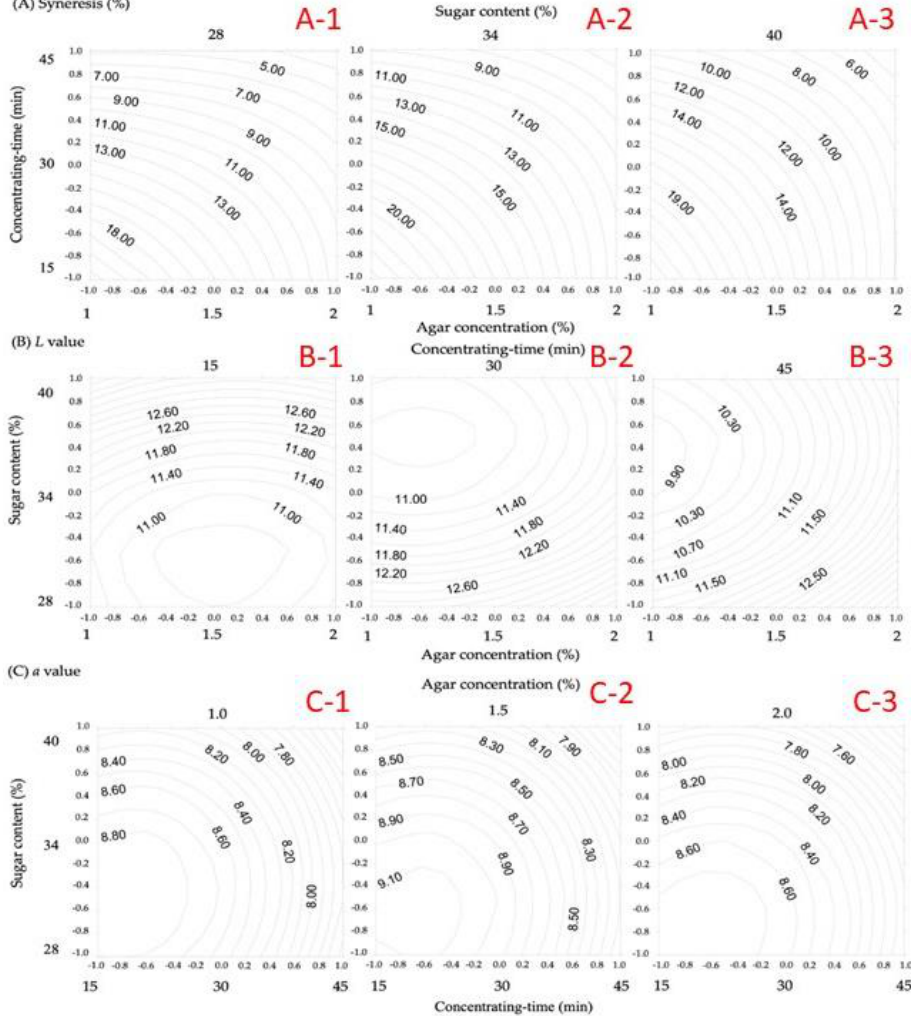
Figure 2. Contour plot of the processing conditions for the gelatinized adzuki-bean cake with respect to syneresis L and a -value.